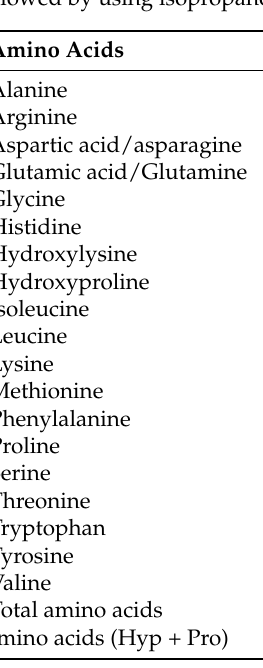
Table 4. Amino acid composition of hydrolyzed collagen powder defatted using DSCS for 9 cycles, followed by using isopropanol for 2 cycles.